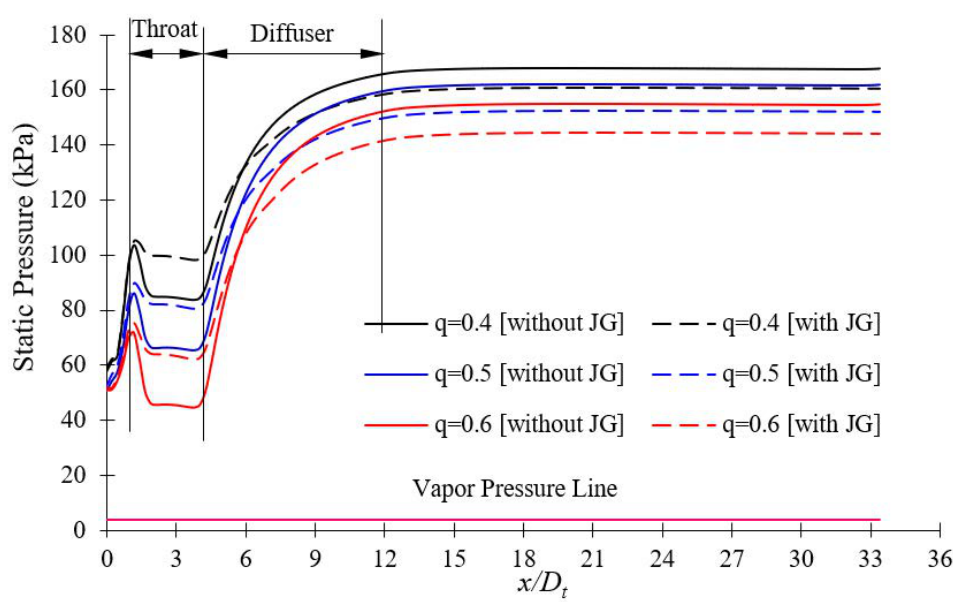
Figure 12. Pressure distribution comparison in the AJP model without and with